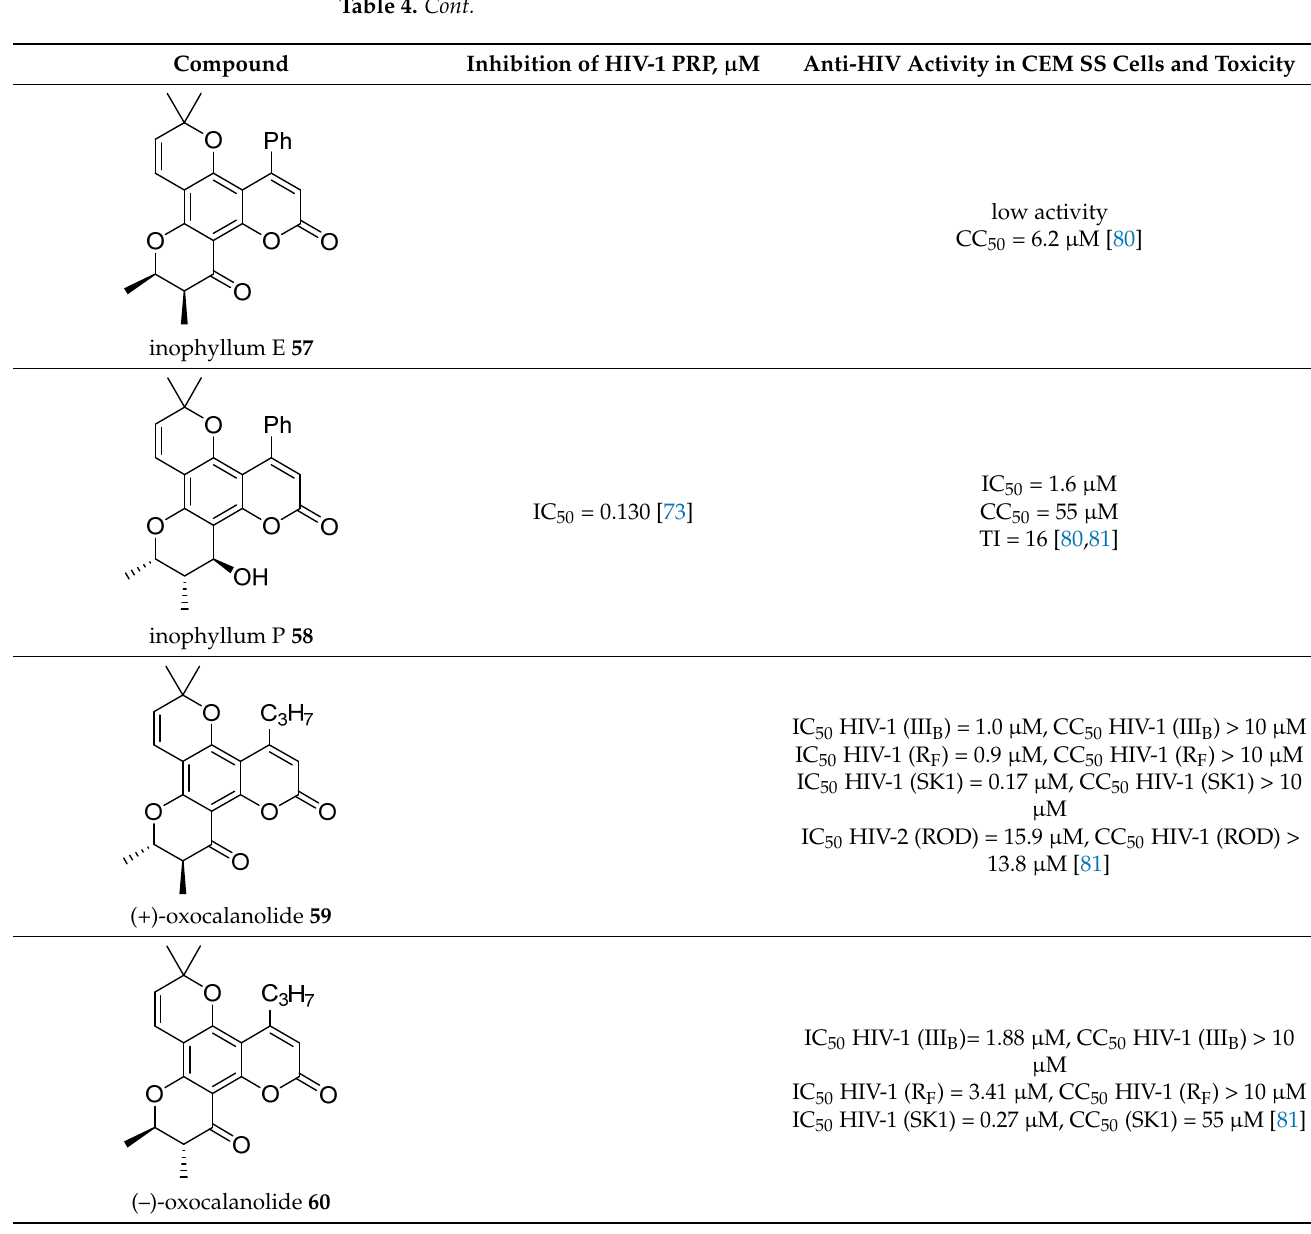
Figure 10. Synthetic calanolide A analogs with anti-HIV activity. Pyranocoumarin GUT-70 64 (Figure 11) was isolated from Calophyllum brasiliense stem bark [88,89]. It stabilized plasma membrane fluidity, inhibited HIV-1 entry, and down-regulated the expression of chemokine receptors CXCR4, CD4, and CCR5. GUT-70 also had an inhibitory effect on viral replication through the inhibition of NF- κ B [90]. Therefore, this compound may be a dual-functional and viral mutation-resistant reagent. Another important feature of this compound is that GUT-70 inhibited HIV-1 replication in both acutely and chronically infected cells [91]. The antiviral activity (determined in several cell lines) and toxicity (MTT assay) of GUT-70 are presented in Table 5. Unfortu- nately, despite several mechanisms of action, this compound is characterized by low ther- apeutic